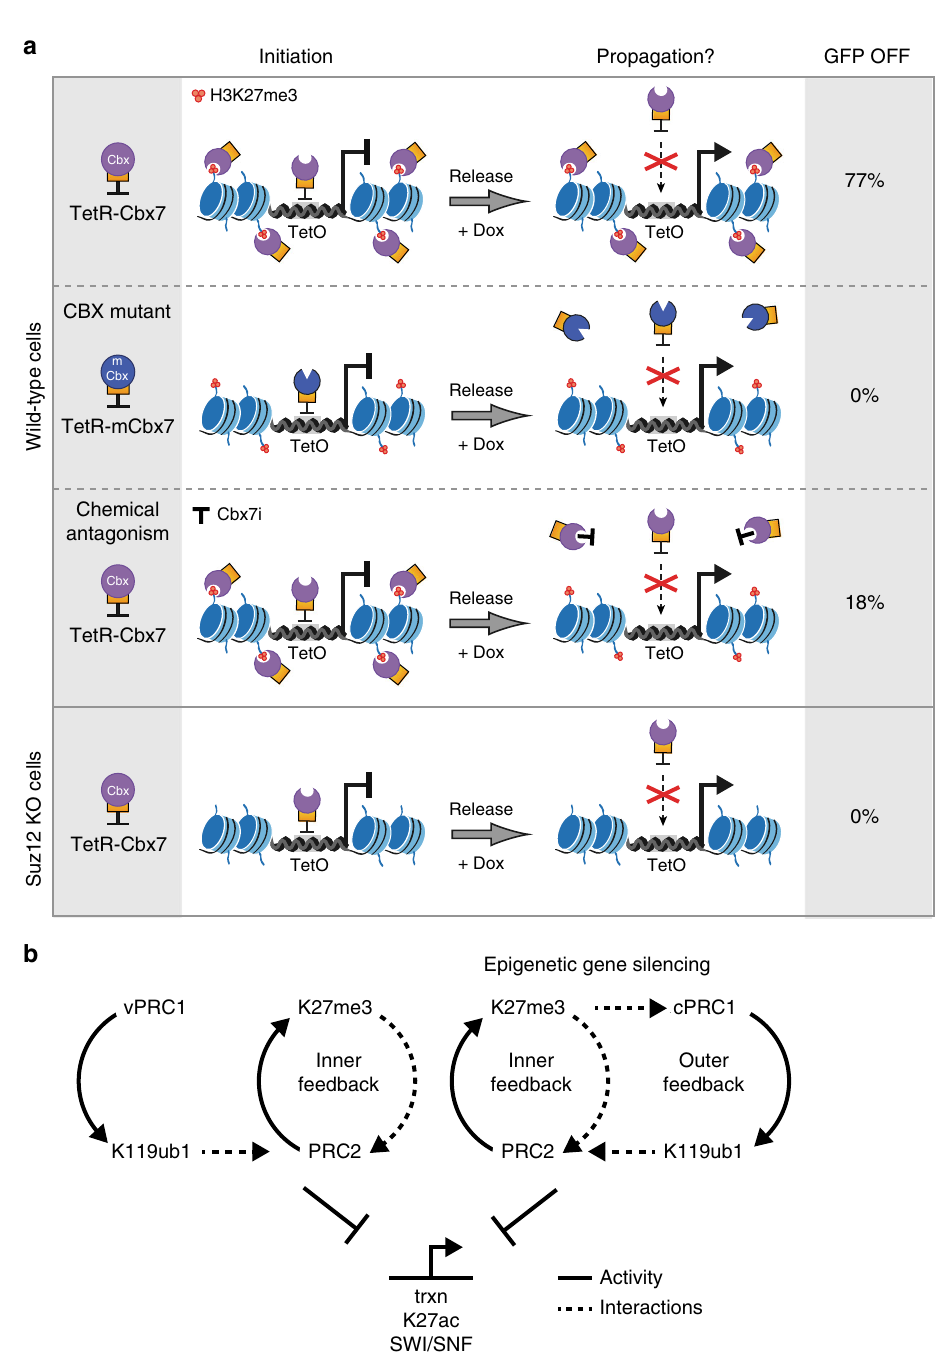
Fig. 5 Summary of key experiments and model of differential epigenetic regulation by cPRC1 and vPRC1. a Schematic representation summarizes the key experiments in support of an interaction between the CBX methyl-lysine recognition domain and H3K27me3 promoting sequence-independent, heritable propagation of cPRC1 recruitment and gene silencing. Results of tethering and release of TetR-Cbx7 or TetR-Cbx7 W35A (TetR-mCbx7) in wild-type and Suz12 LOF TetO-mESCs. Chemical antagonism indicates treatment of TetR-Cbx7 reporter cells with Cbx7i (UNC3866). GFP OFF displays fraction of transcriptionally silent reporter cells. b Model of the regulation of canonical and variant PRC1 complexes in relation to PRC2. Only cPRC1 and PRC2 engage in a reciprocal feedback mechanism to promote sequence-independent epigenetic gene silencing. Arrows indicate catalytic activity of different PcG complexes. Dashed arrows indicate interactions with histone modi fi cations. Stop bars highlight antagonistic